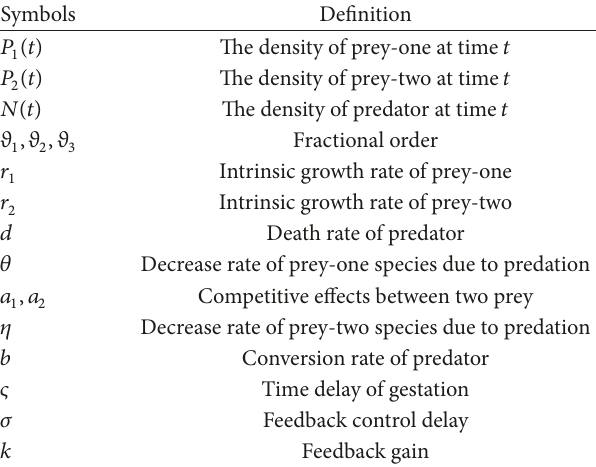
Table 1: Variables and parameters